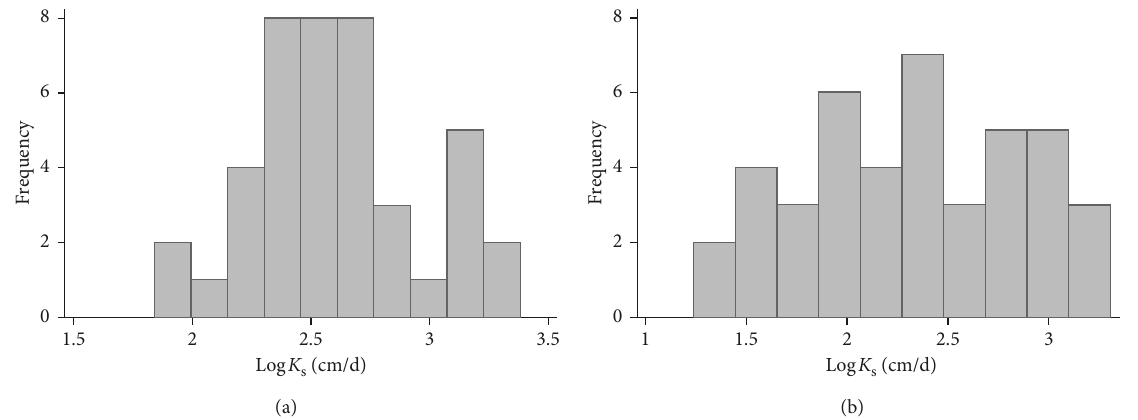
Figure 3: Histograms of